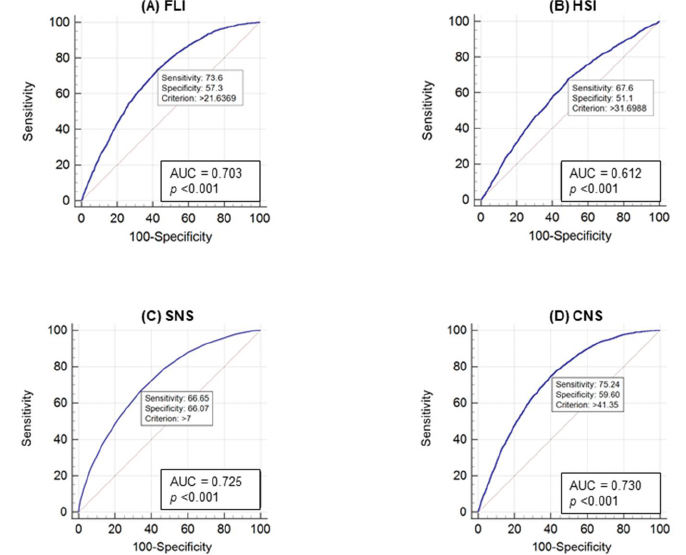
Figure 1. Receiver operating characteristic curve for the prediction of high-risk cardiovascular group inclusion according to NAFLD diagnostic tools. ( A ) Fatty Liver Index. ( B ) Hepatic Steatosis Index. ( C ) Simple NAFLD Score. ( D ) Comprehensive NAFLD Score. AUC, area under the curve.